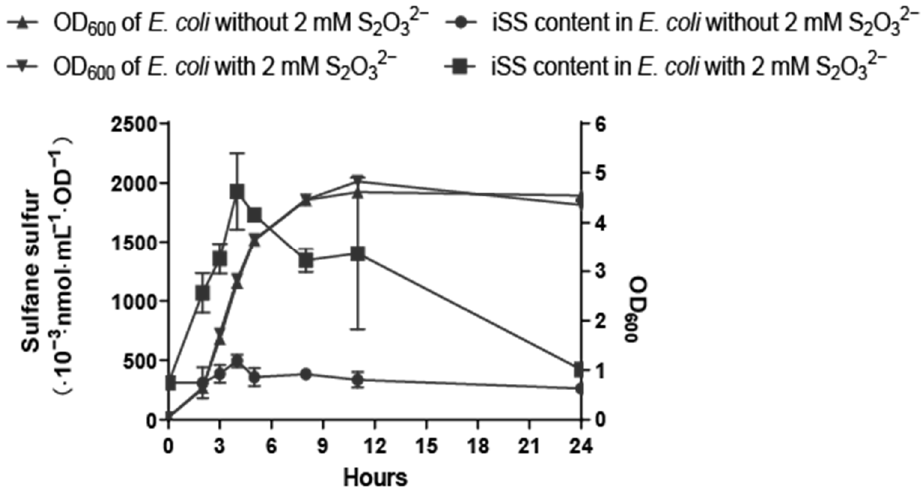
Figure 8. The addition of S 2 O 32 − increased iSS contents in E. coli during growth in LB medium. E. coli BL21(DE3) cells were inoculated into fresh LB medium with or without 2 mM S 2 O 32 − and cultured at 37 °C. The cells at defined time intervals were taken, and the OD 600 and iSS contents were determined. Three parallel experiments were performed to obtain the averages and standard deviations (n = 3).